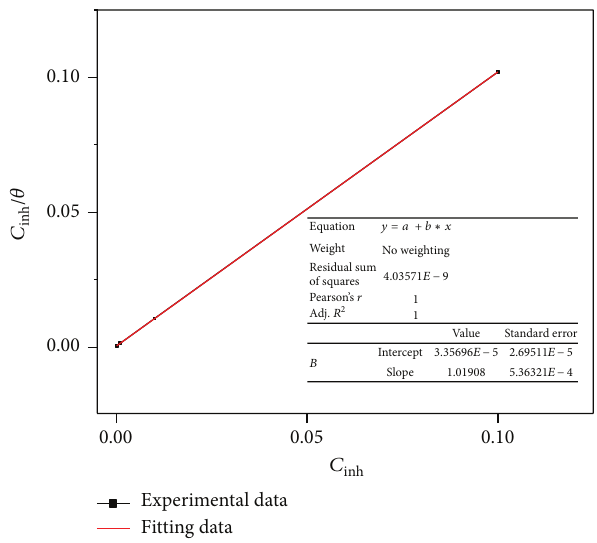
Figure 6: Langmuir adsorption isotherm model for N80 in 15% HCl containing a mix of the inhibitors TU + HMTA at 25 ± 1 ∘